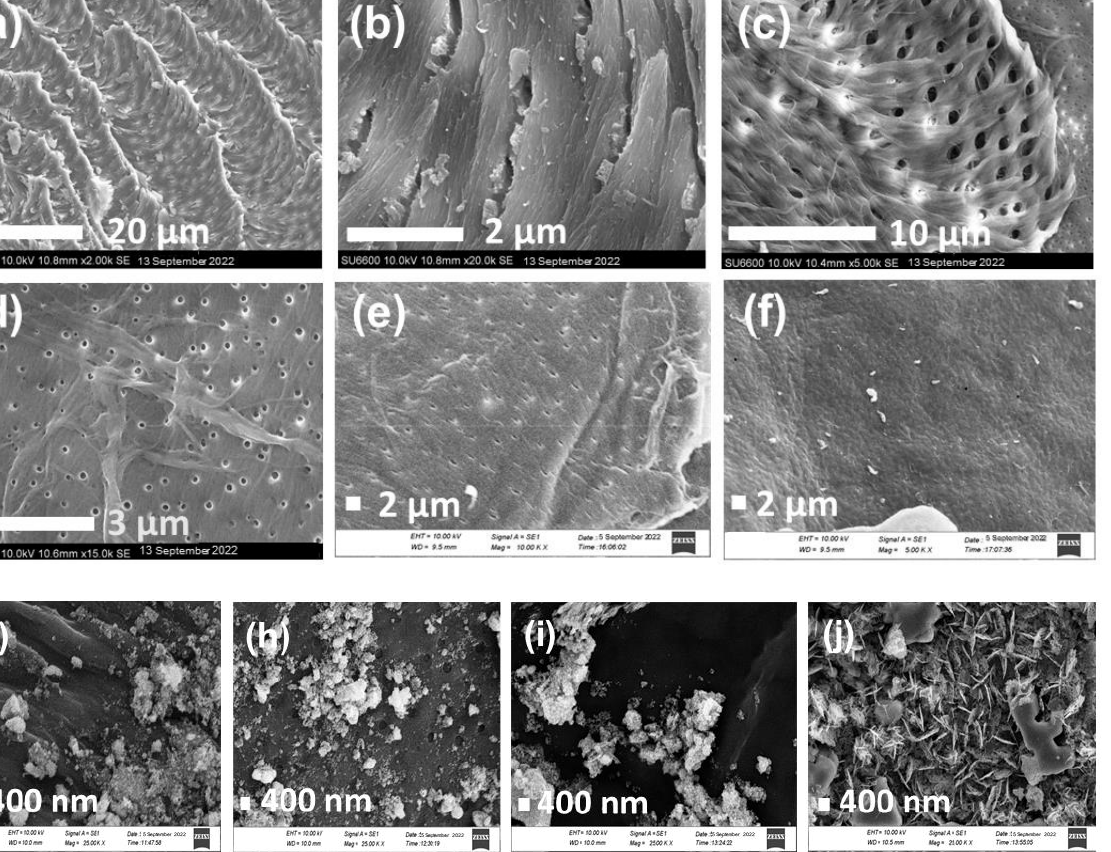
Figure 3. SEM images of ( a ) shrimp shells, ( b ) demineralized shrimp shells, ( c ) deproteinated shrimp shells, ( d ) chitosan, ( e ) pyrolyzed chitosan, ( f ) IL, ( g ) CIL (1:1), ( h ) CIL (3:4), ( i ) CIL (1:2) and ( j ) CIL (1:4).